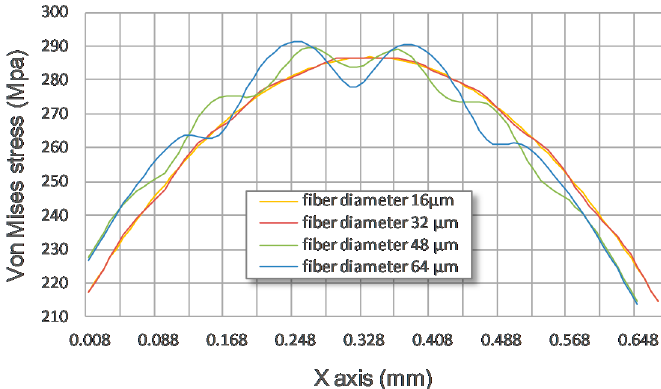
Figure 20. Stress distribution at line 1 for the four stress fields with an increasing SiC fiber diameter.